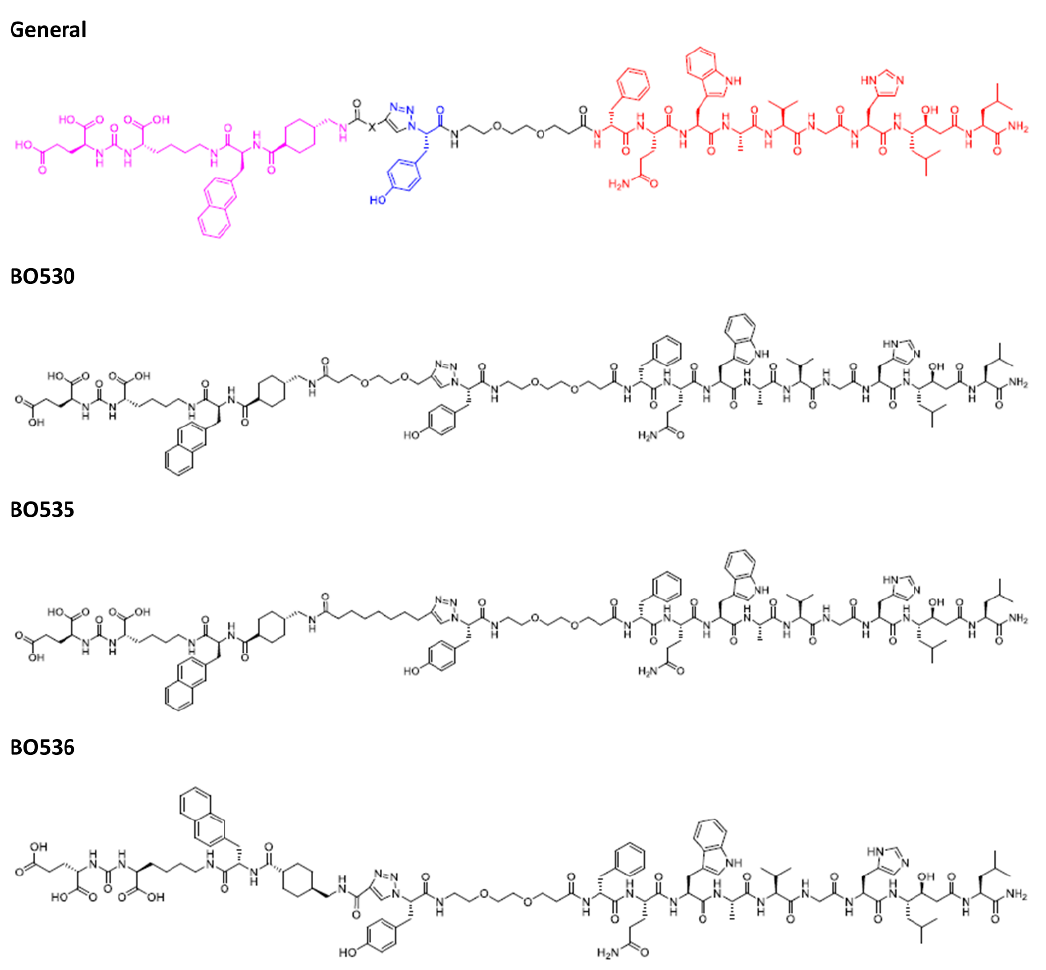
Figure 1. General structure of the heterodimers with a X indicating different linkers. The gastrin-releasing peptide receptor (GRPR) binding part is red, the prostrate-specific membrane antigen (PSMA)-binding part is magenta and the tyrosine for radio-iodonation is blue.